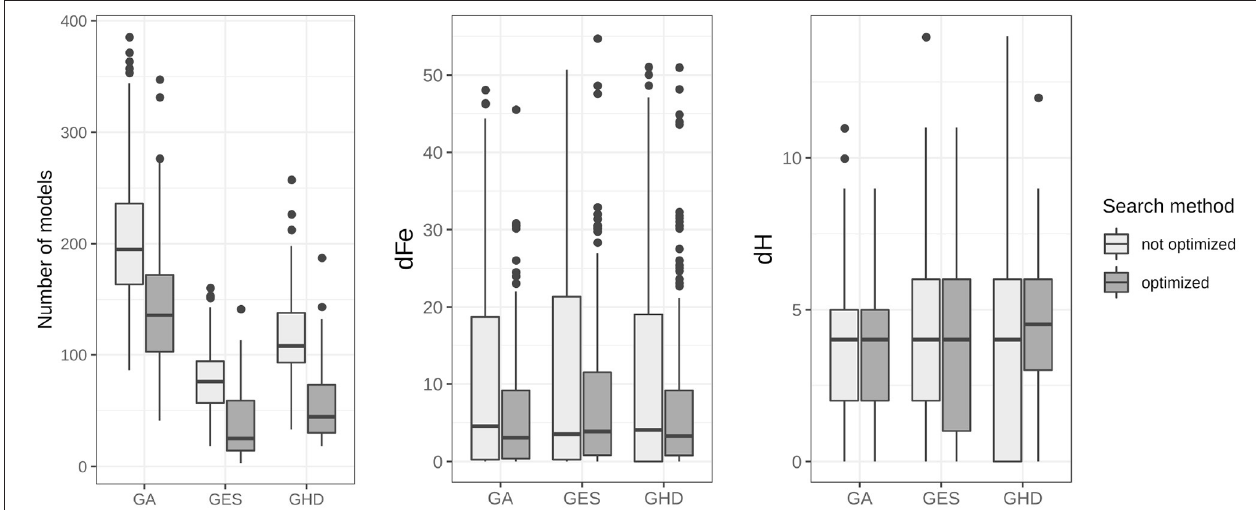
FIGURE 4 | Summary of model search results for topological search algorithms. The accumulated number of estimated models, the dFe and the Hamming-distance of each of the three model search methods are displayed for all 20 runs on each of the 10 subject data. Box-and-whisker diagrams show the median, first and third quartiles of search results with the 95% confidence interval of the median. The improved version of the algorithms needed significantly lower number of models to calculate during search, with p < 0.001 for each algorithm.